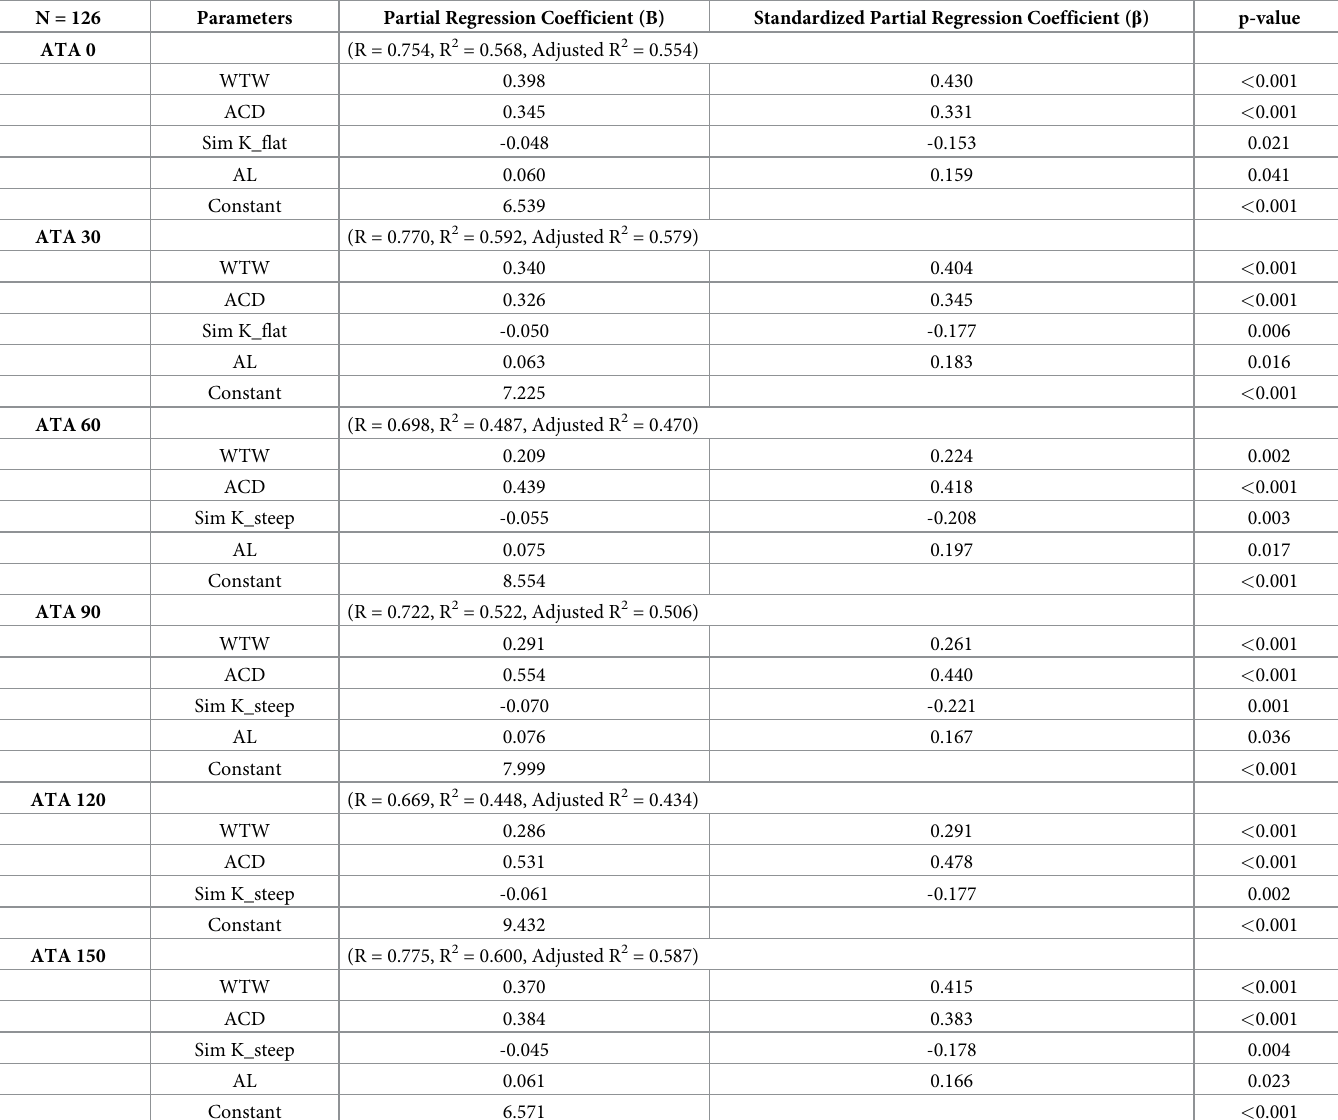
Table 6. Results of the stepwise multivariate regression analysis with age, axial length, manifest refraction spherical equivalent, horizontal WTW, anterior chamber depth, and Sim K (steep and flat) at angle-to-angle diameter. N = 126